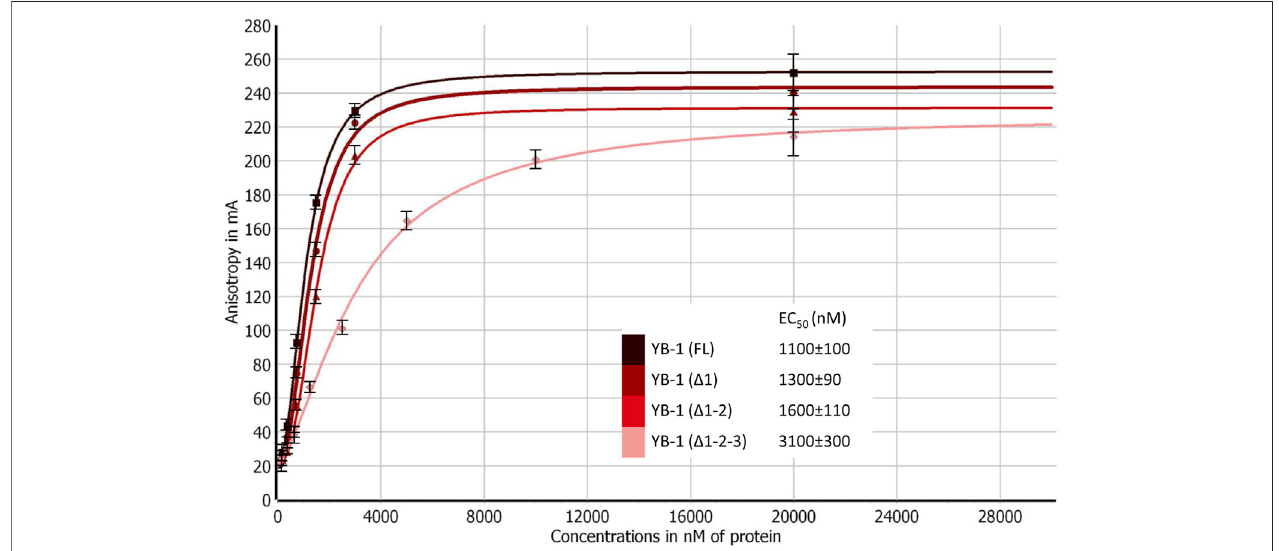
FIGURE 3 | CTD shortening weakens YB-1 af fi nity for damaged DNA. Titrations of FAM-labeled DNA with YB-1(FL) or one of its deletion mutants. The reaction mixtures contained 50 nM FAM-labeled DNA duplex and either YB-1(FL) or one of its C-terminal deletion mutants as indicated. Graphs represent the mean values of three independent experiments with error bars representing ± SD. EC 50 values are the mean (±SD) of at least three independent experiments.